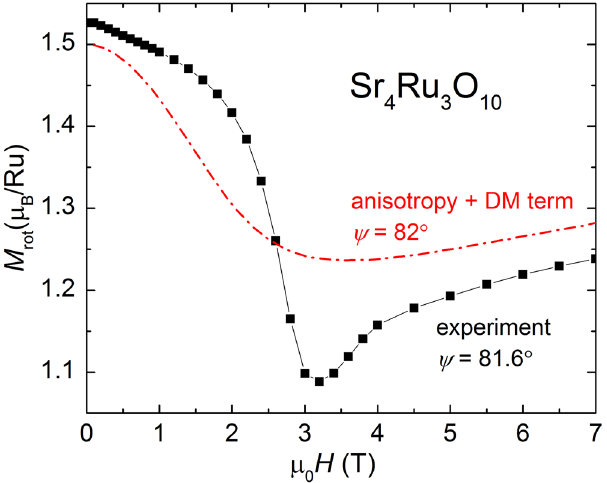
Figure 8. Experimental magnetization modulus M rot (symbol) in the plane of rotation as a function of magnetic field μ 0 H up to 7 T and numerical results including tetragonal magnetocrystalline anisotropy and a DM alike energy term (broken line) for ψ ≃